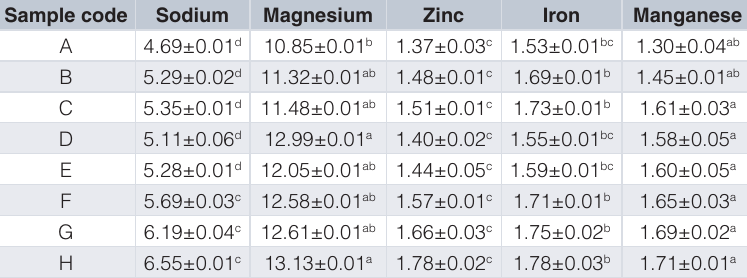
Table 3. Mineral Content (mg/100g) of Ogi (maize) flour with Garlic and Ginger.